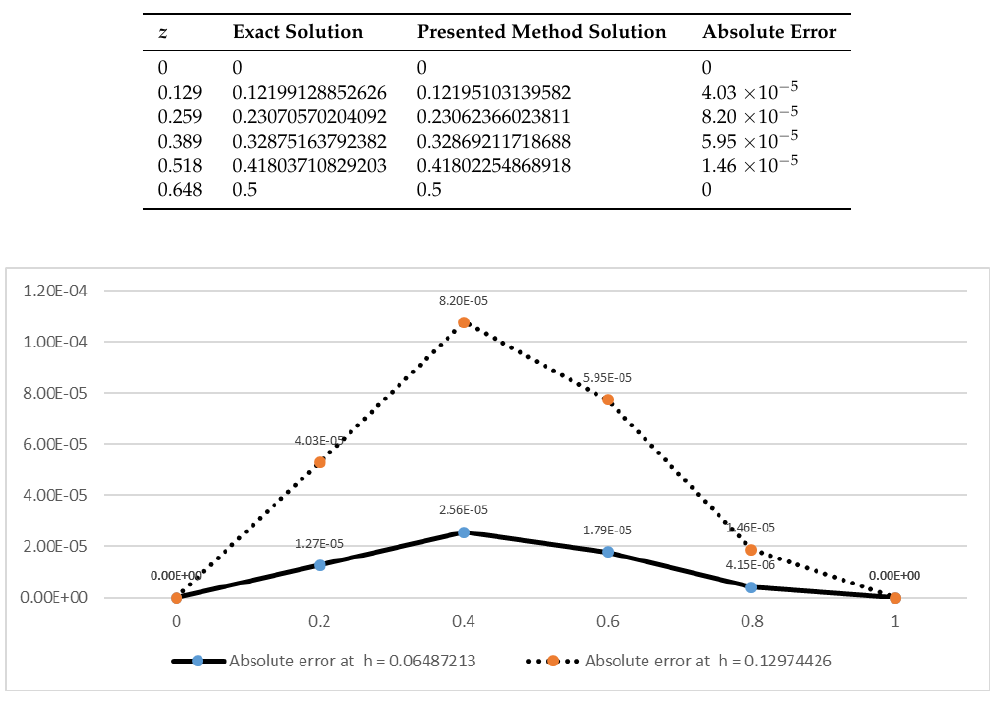
Figure 5. Graphical comparison of Problem 5 at h = 0.06487213 and h = 0.12974426. Absolute errors at all derivatives are described in Table